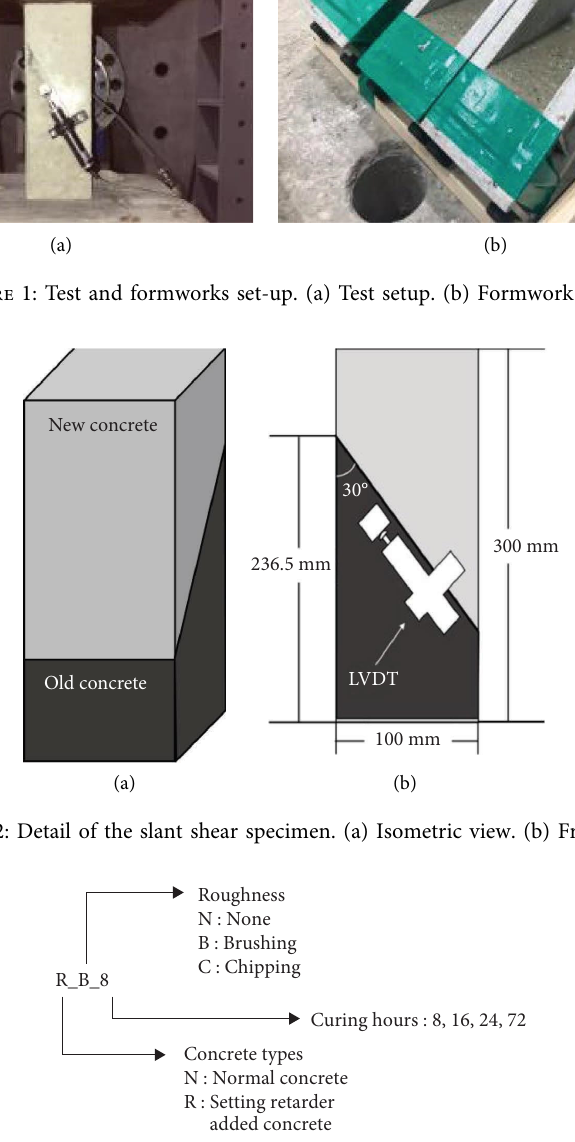
Figure 3: Sample notation of the specimen